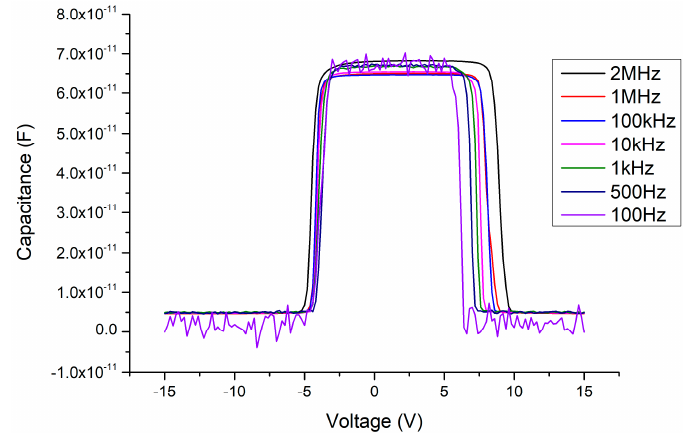
Figure 13. C–V measurement results of the MOSOM varactor (with a 156 nm thick Ga 2 O 3 thin film) from − 15 to +15 V.